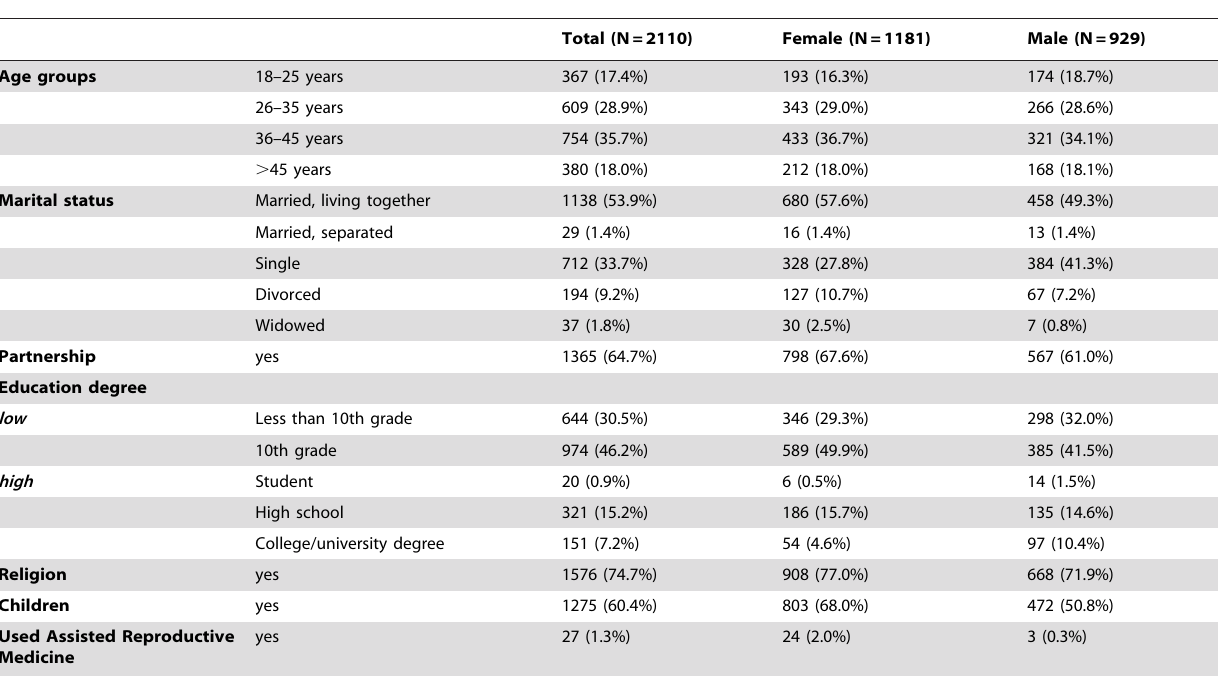
Table 1. Socio-demographic characteristics of the sample.